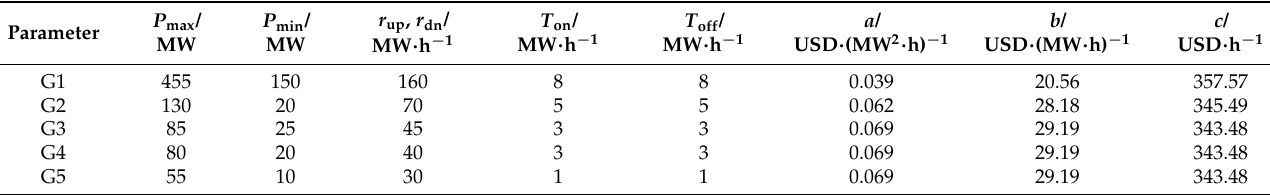
Table 2. Electricity price demand elasticity matrix coefficient. Time interval Talley Tlat